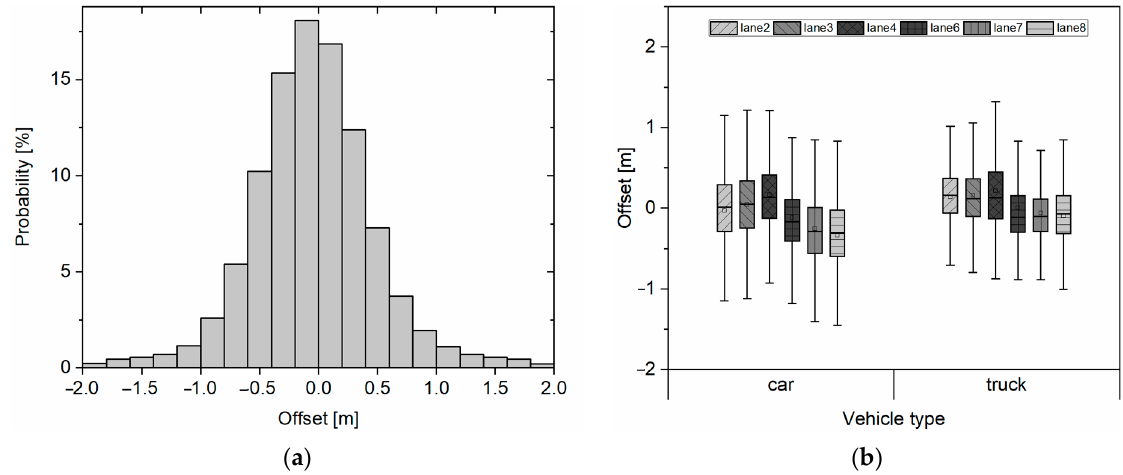
Figure 11. ( a ) Probability distribution of offset; ( b ) Offset for car and truck in different lanes.